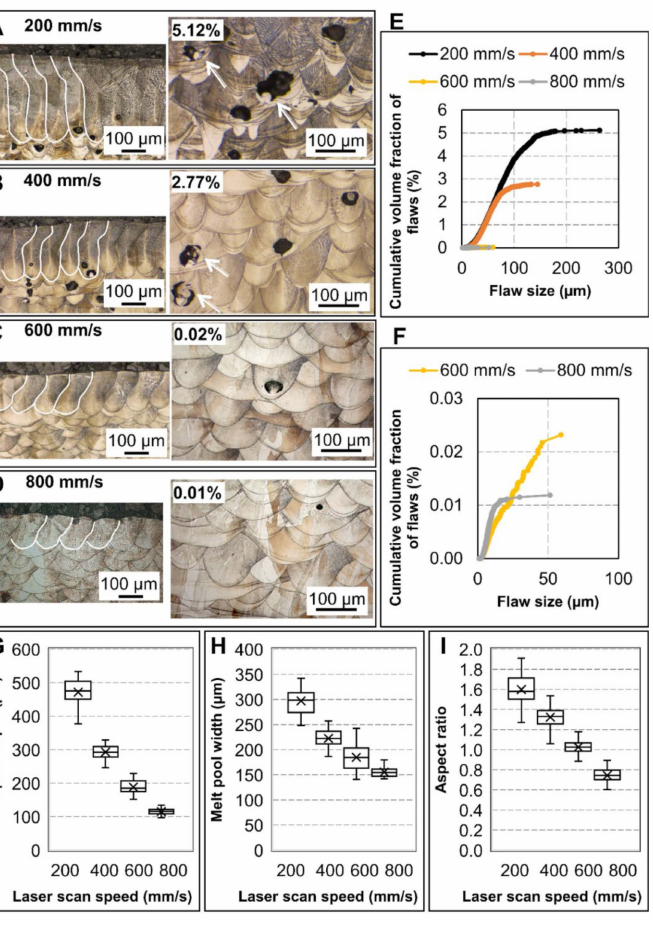
Figure 2. Influence of laser scan speed on melt pool geometries and flaw populations in the key- hole regime. Microstructure of specimens manufactured with laser scan speed of: 200 mm/s ( A ); 400 mm/s ( B ); 600 mm/s ( C ); 800 mm/s ( D ); otherwise identical parameters (nominal laser power 200 W and layer thickness 40 µ m). The volume fraction of flaws is indicated. Melt pool boundaries are highlighted for easier visualization. Arrows indicate keyhole pores of irregular morphology. Corresponding flaw size distributions ( E ) and detailed view for specimens with low flaw content ( F